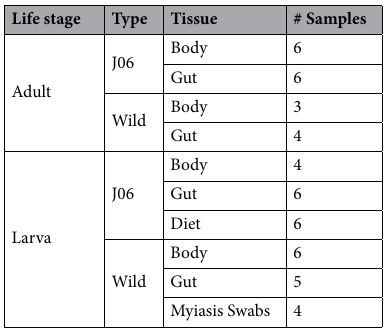
Table 1. Overview of samples used for the analysis of C. hominivorax